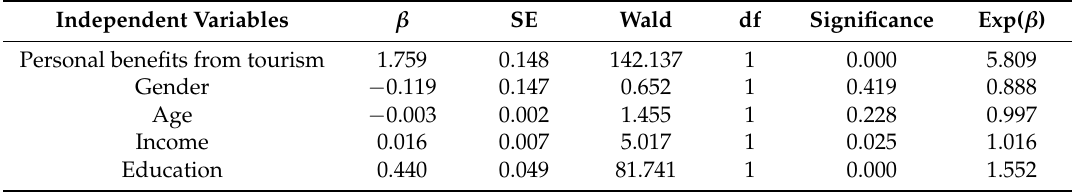
Table 2. Results of logistic regression analysis for respondents in the spatial clustering of positive tourism impacts.